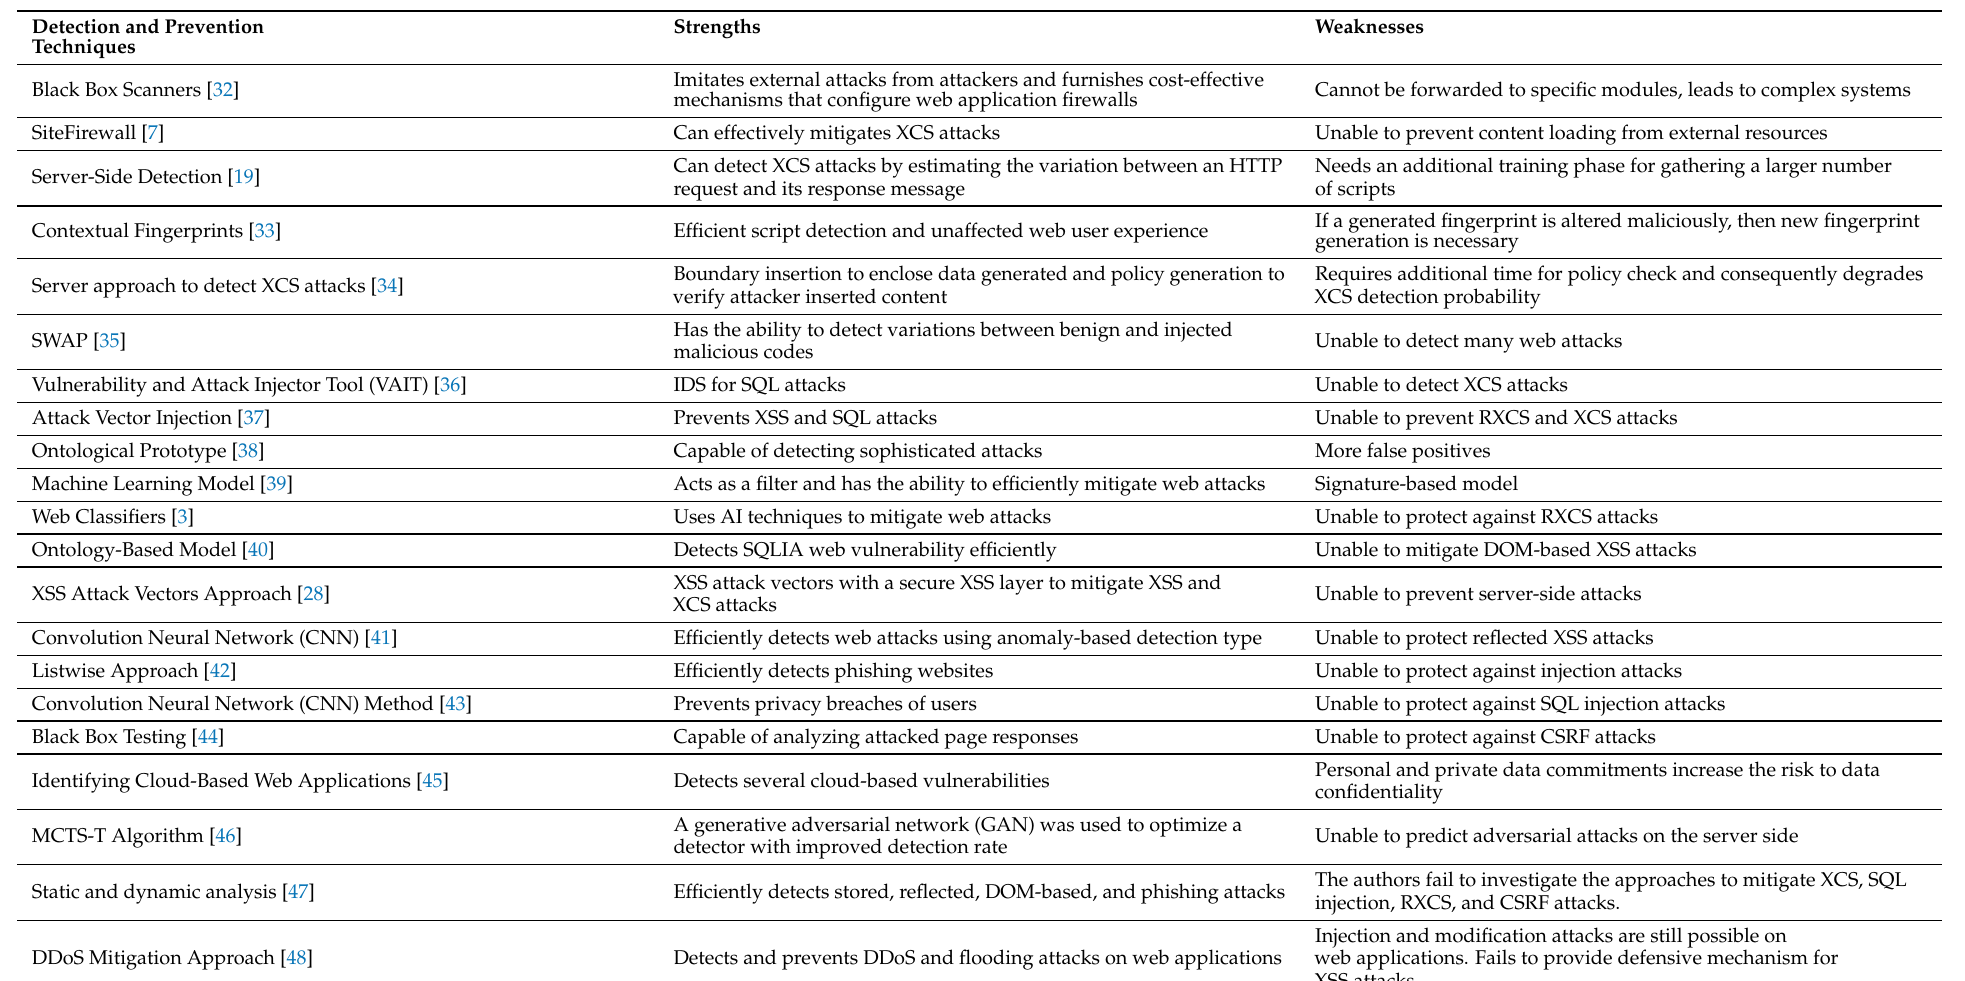
Table 1. Comparison of XCS detection and prevention